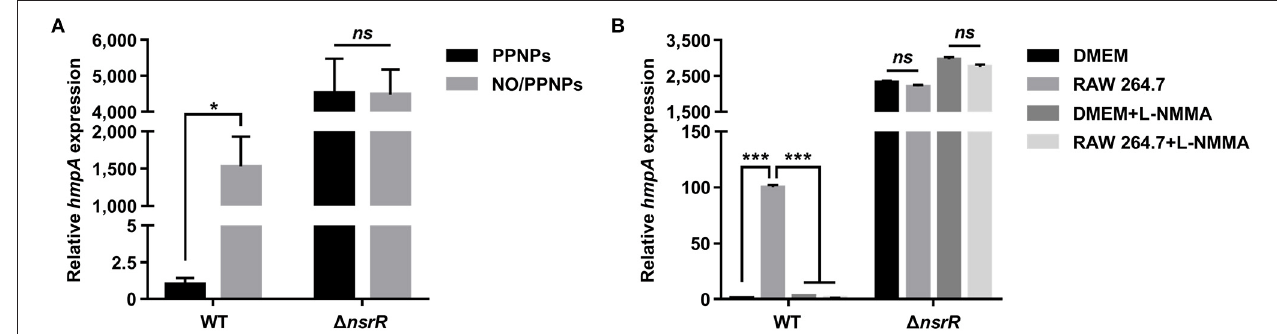
FIGURE 2 | The effect of nitrosative stress and the nsrR mutation on hmpA transcription in vitro and ex vivo . The wild-type and 1 nsrR strains were grown aerobically to an A 600 of 0.5, and then exposed to 0.15 mg/ml NO/PPNPs in vitro (A) or NO-producing RAW 264.7 cells ex vivo in the presence or absence of L-NMMA (B) for 10min. The hmpA transcript levels were determined by qRT-PCR, and the hmpA transcript levels in the wild-type strain exposed to PPNPs (A) or DMEM without L-NMMA (B) were set to 1. Error bars represent the SD. Statistical significance was determined by the Student’s t -test (* p < 0.05; *** p < 0.0005; ns , not significant). WT, wild type; 1 nsrR , nsrR- deletion